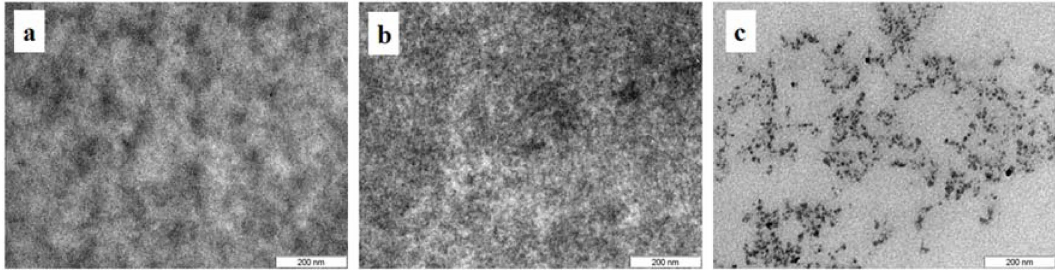
Figure 2. TEM micrographs of hybrid materials at 120 K magnifications of ( a ) DGEBA/PEI-Si 50/50; ( b ) DGEBA/PEI-Si/GPTMS 50/50/40; and ( c ) DGEBA/PEI/TEOS